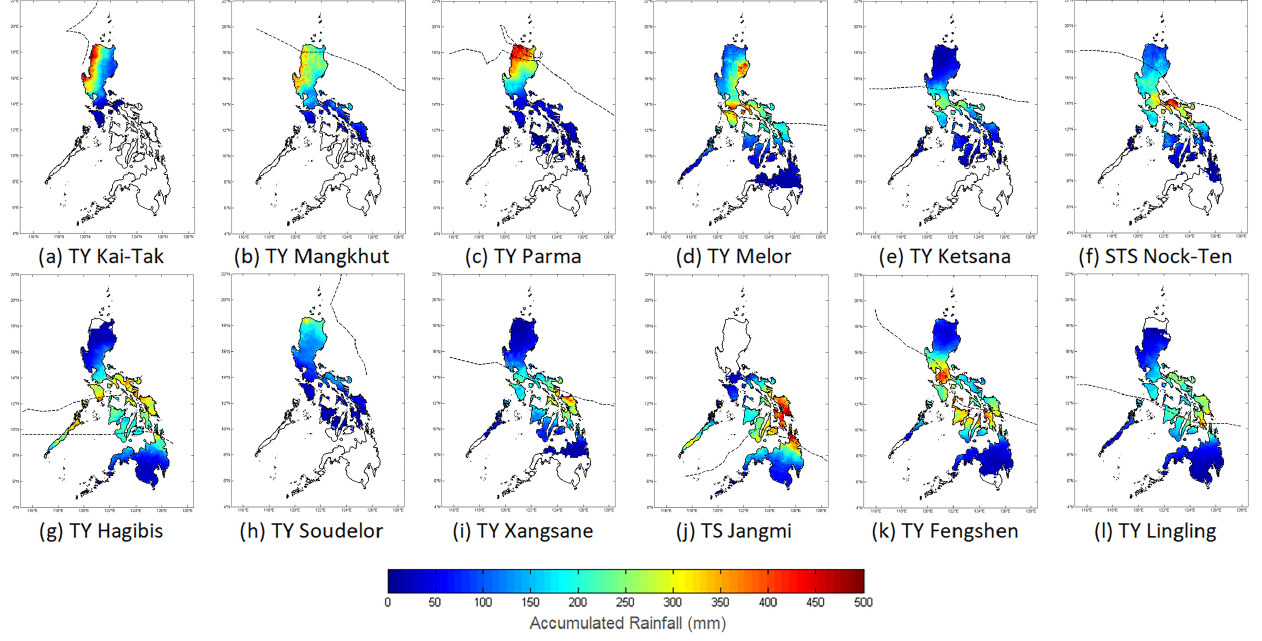
Figure 9. Same as Figure 8 but for